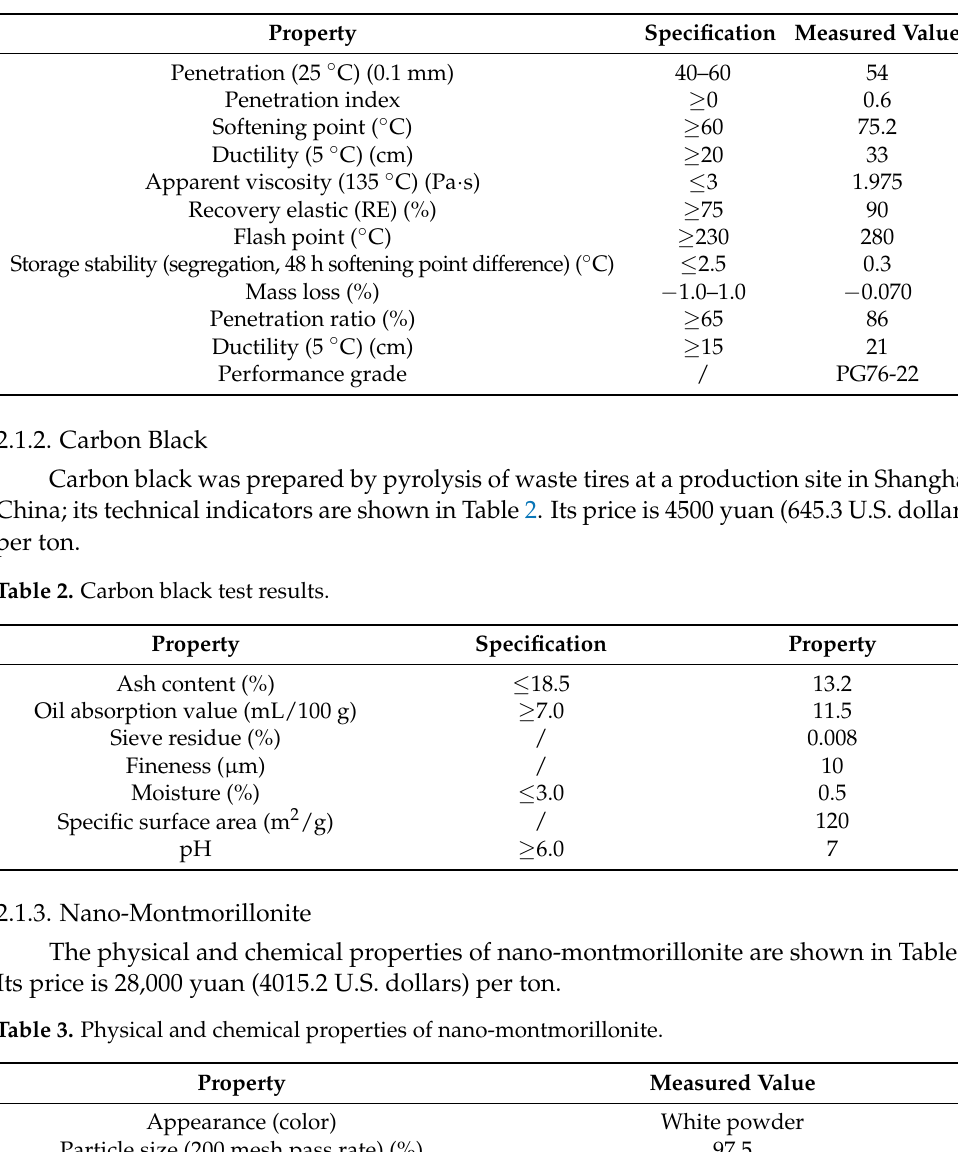
Table 1. Basic physical properties of the SBS-modified asphalt.